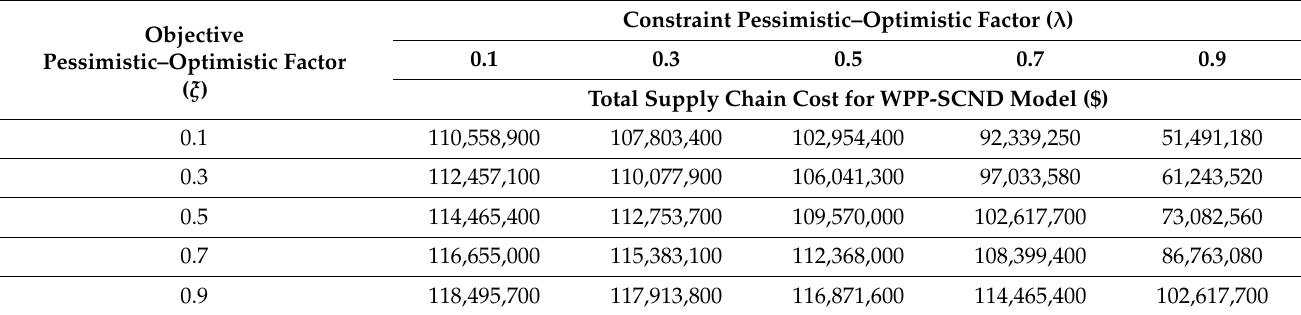
Table 3. Effect of variation in objective pessimistic–optimistic factor ( ξ ) and constraint pessimistic- optimistic ( λ ) factor on the objective of the WPP-SCND